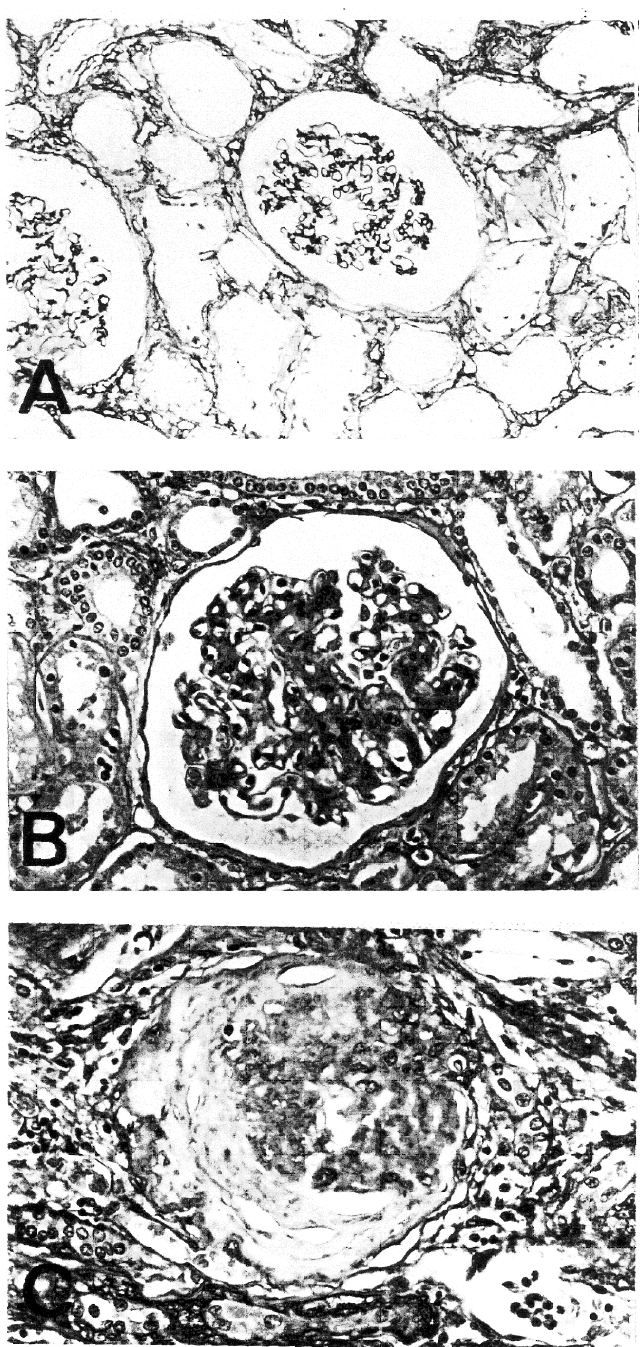
Fig. 1. Immunohistochemical staining of type VI collagens in a control glomerulus (A), showing weak staining in the mesangium, GBM and Bowman’s capsule. Note strong immunostaining for type VI collagen in the diffuse sclerotic le- sion of a diabetic glomerulus (B) and moderate immunostaining in the late stage of a globally sclerotic glomerulus (C) (immunoperoxidase